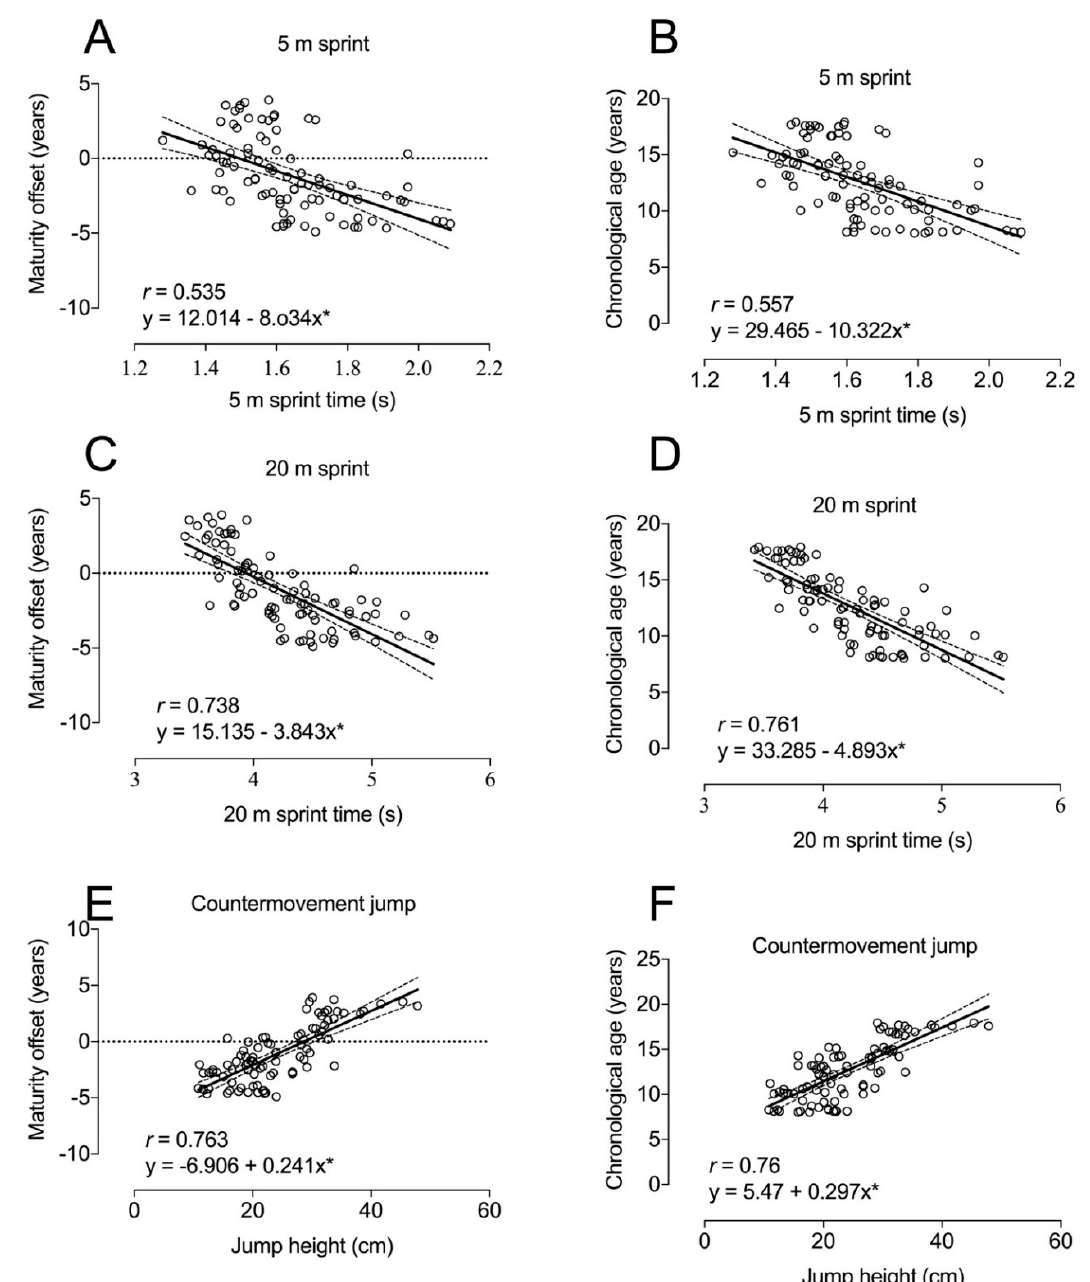
Figure 1. Associations between the performance in 5 m sprint, 20 m sprint, and countermovement jump, and maturity offset ( A , C and E , respectively), and chronological age ( B , D and F , respectively). Significant correlations: * p < 0.001. Partial correlations between 5 m, 20 m, and CMJ height and maturity offset controlling for training experience and body size were r = 0.23 p = 0.034), and 0.4 and 0.54 ( p < 0.001), respectively. Partial correlations between 5 m, 20 m, and CMJ height and chronological age controlling for training experience and body size were r = 0.25 ( p = 0.02), 0.45, and 0.56 p < 0.001), respectively. Descriptive statistics of the different components of the vertical and horizontal F-V profiles, and Pearson correlation coefficients between them and both maturity offset and chronological are displayed in Table